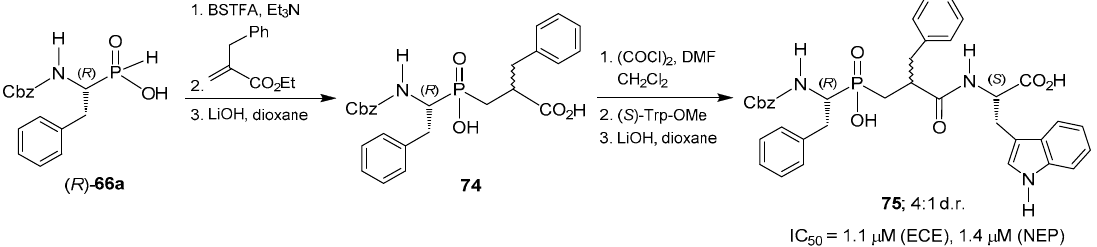
Scheme 32. Synthesis of the C -phosphinic acid 75 and its activities as inhibitor of